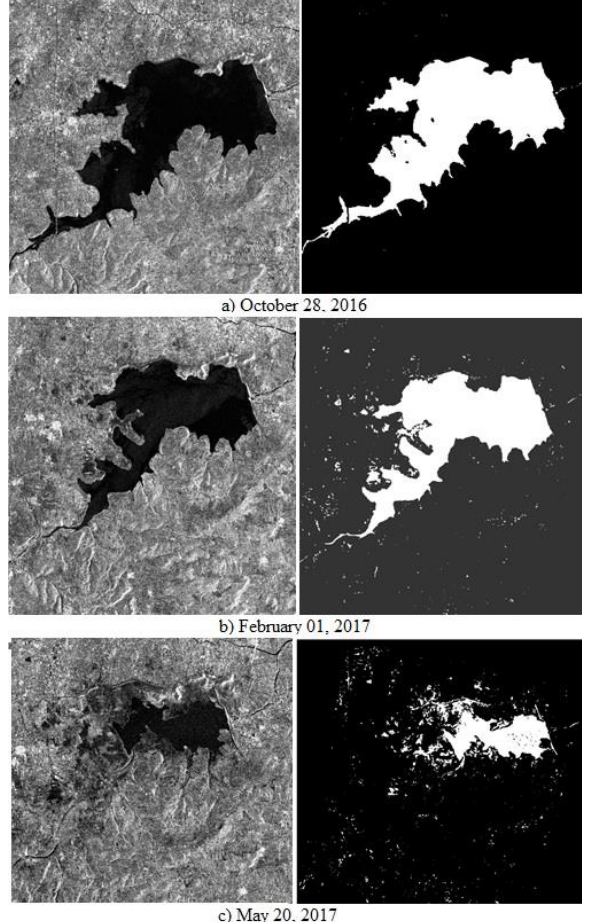
Figure 5. Water pixel extracted from Sentinel-1A data of Ghataprabha